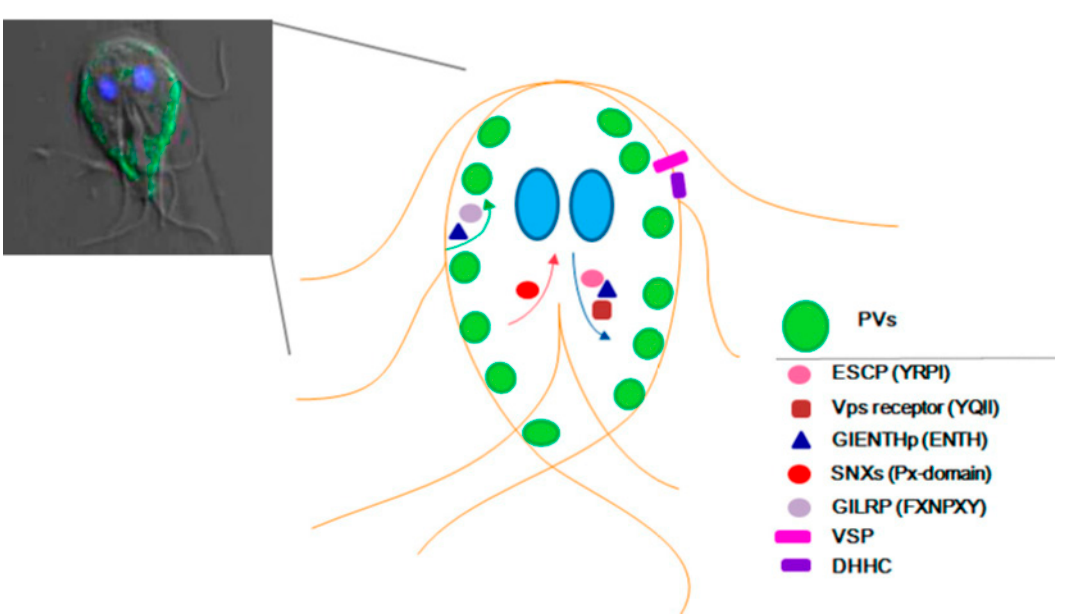
Figure 2. Schematic representation of Giardia lamblia proteins localization. Left panel, confocal microscopy merged image showing differential interference contrast, encystation-specific cysteine protease (ESCP)-HA localization in the PVs (green), and the nuclei labelled with DAPI (blue). The right panel shows a draw of proteins that travel from the plasma membrane to the PVs (green arrow), those that use the retromer transport (red arrow), the ones that go from the ER to the PVs (blue arrow), and the integral membrane proteins. Only the proteins with demonstrated experimental localization are denoted. SNXs: sorting nexins.